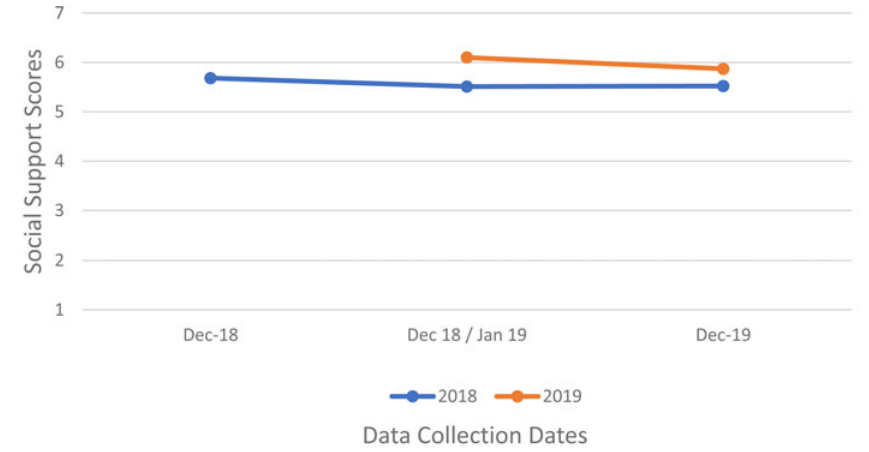
Fig. 2. Social Support Mean Scores for 2018 & 2019